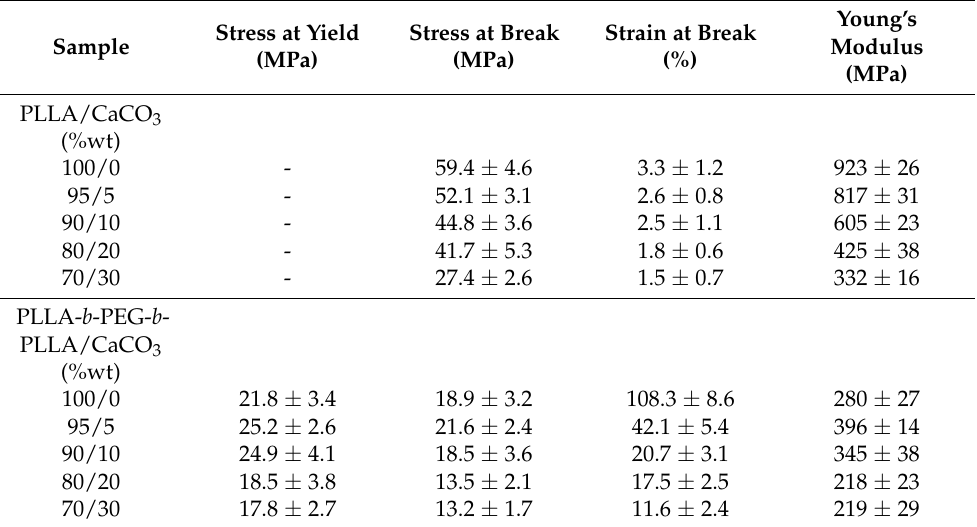
Figure 9. Stress–strain curves of ( a ) PLLA/CaCO 3 and ( b ) PLLA- b -PEG- b -PLLA/CaCO 3 films with various CaCO 3 ratios. Table 5. Averaged tensile properties of the composite films.